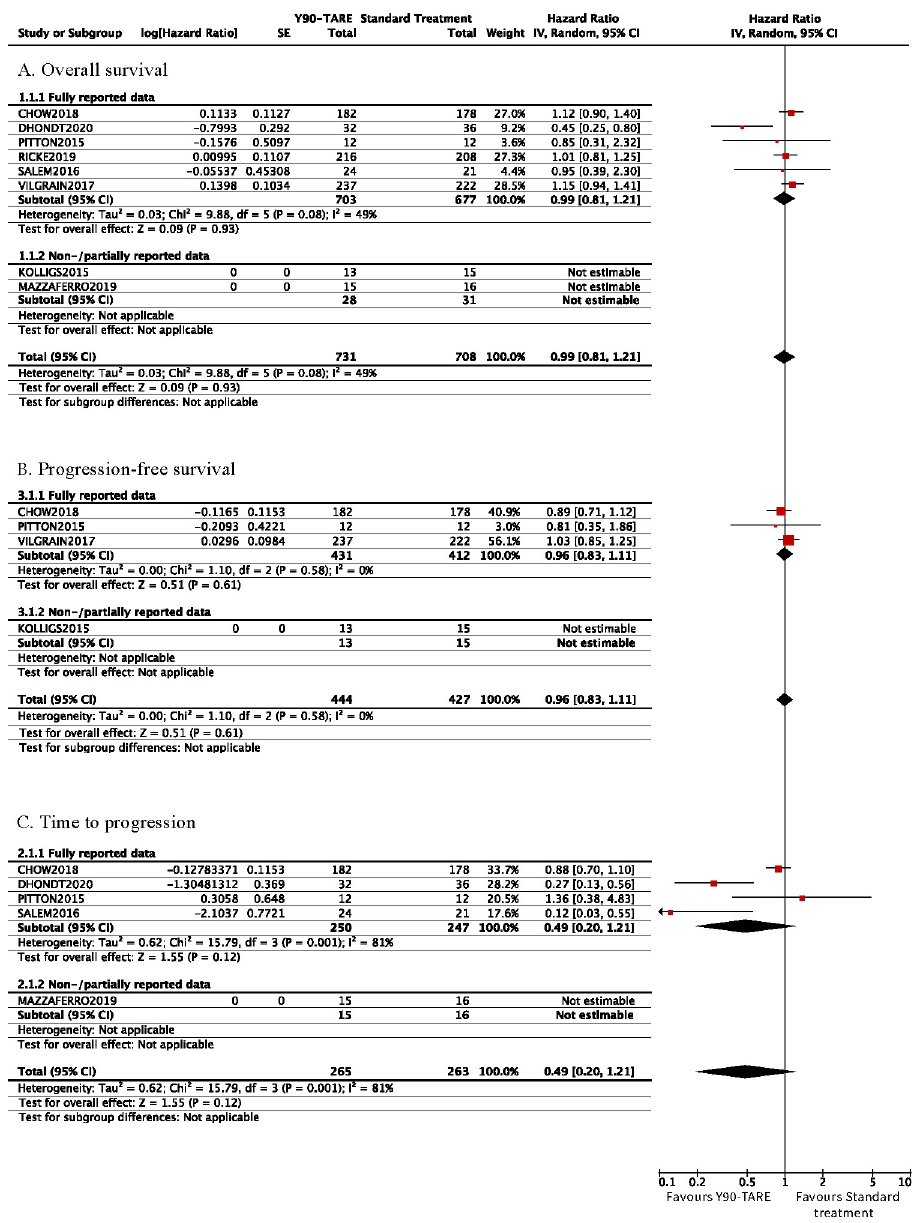
Fig 3. Forest plot of time-to-event outcomes. Cumulative (log)HR estimates with their 95% confidence intervals in the random-effects model for (A) overall survival, (B) progression-free survival, and (C) time to progression.